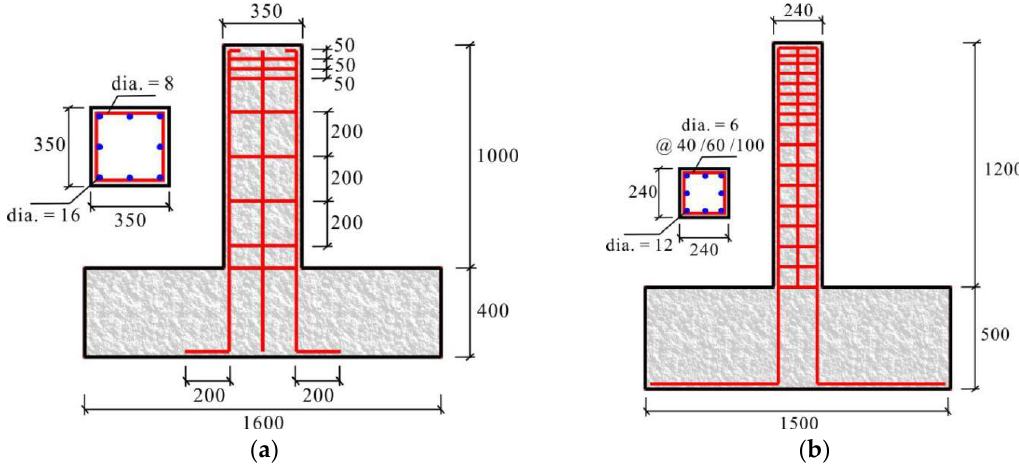
Figure 2. Reinforcement and geometry diagram of reported specimens (unit: mm). ( a ) Specimens in Xiao et al. [42], and ( b ) specimens in Yang [43].